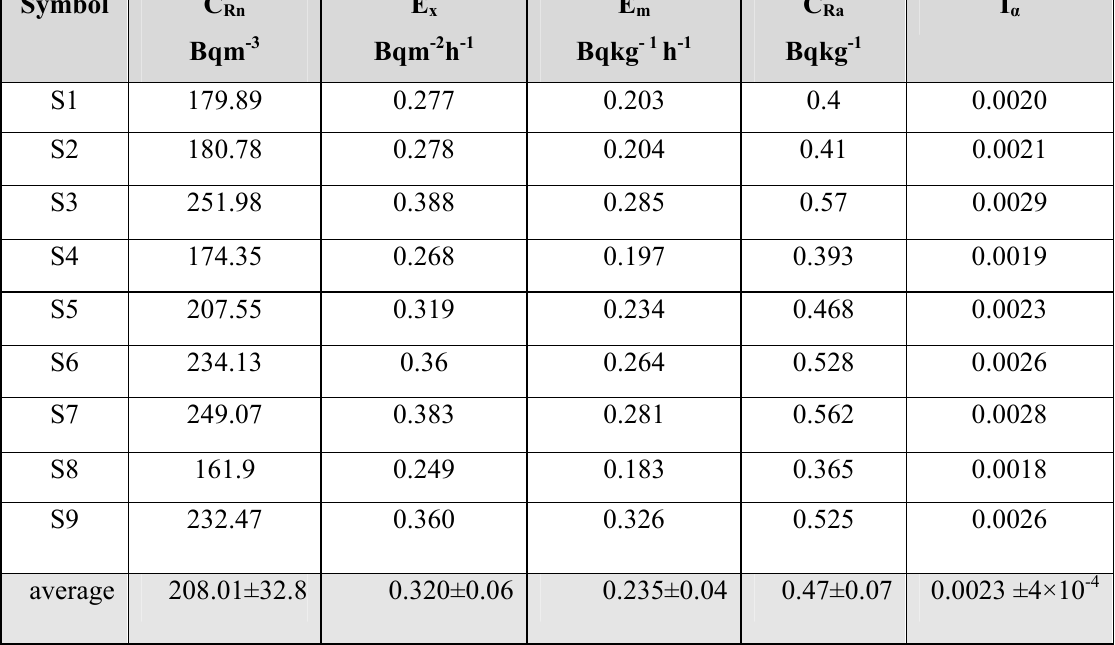
Table 2: Radon gas concentration, surface exhalation rate, mass exhalation rate, radium concentration and alpha index for fertilizer